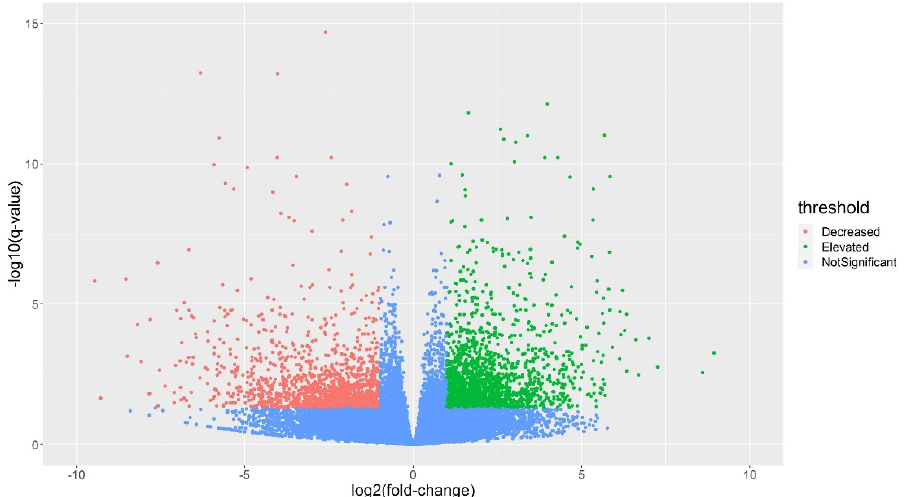
Figure 4. Volcano plots of differentially expressed genes with statistically significant regulation between FDT and NDT groups. Note: Green dots represent genes that are significantly higher expressed in FDT group, while red dots represent genes that are significantly lower expressed in FDT group and blue dots represent those with no significant difference.